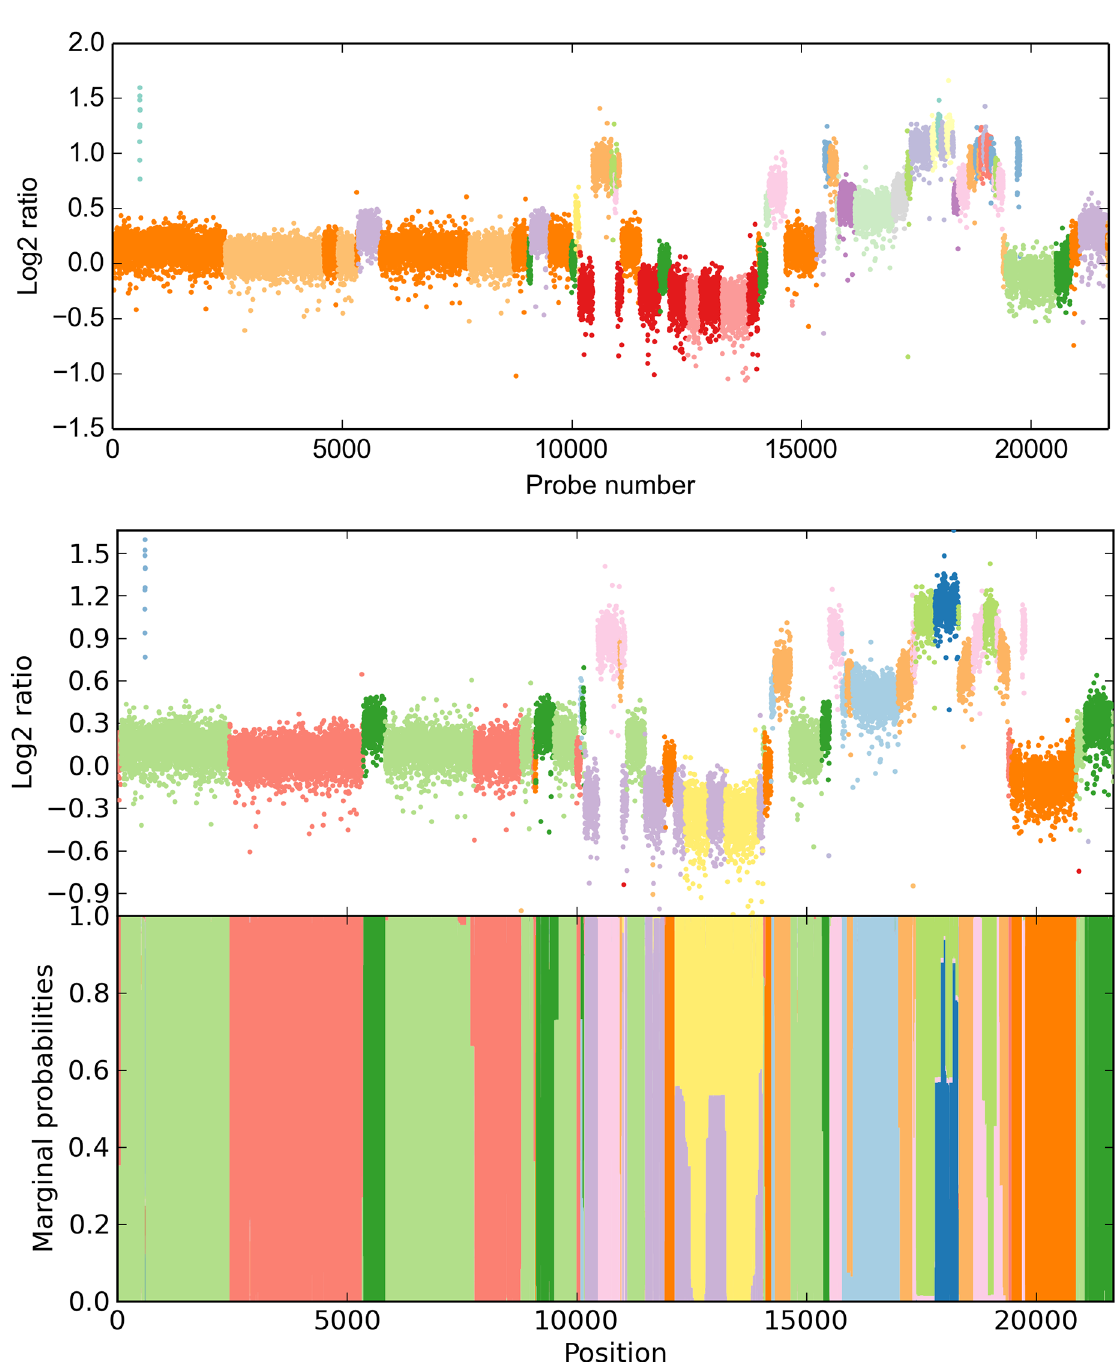
Fig 3. Copy number inference for chromosome 20 in invasive ductal carcinoma (21,687 probes). CBS creates a 19-state solution (top), however, a compressed 19-state HMM only supports an 11-state solution (bottom), suggesting insufficient level merging in